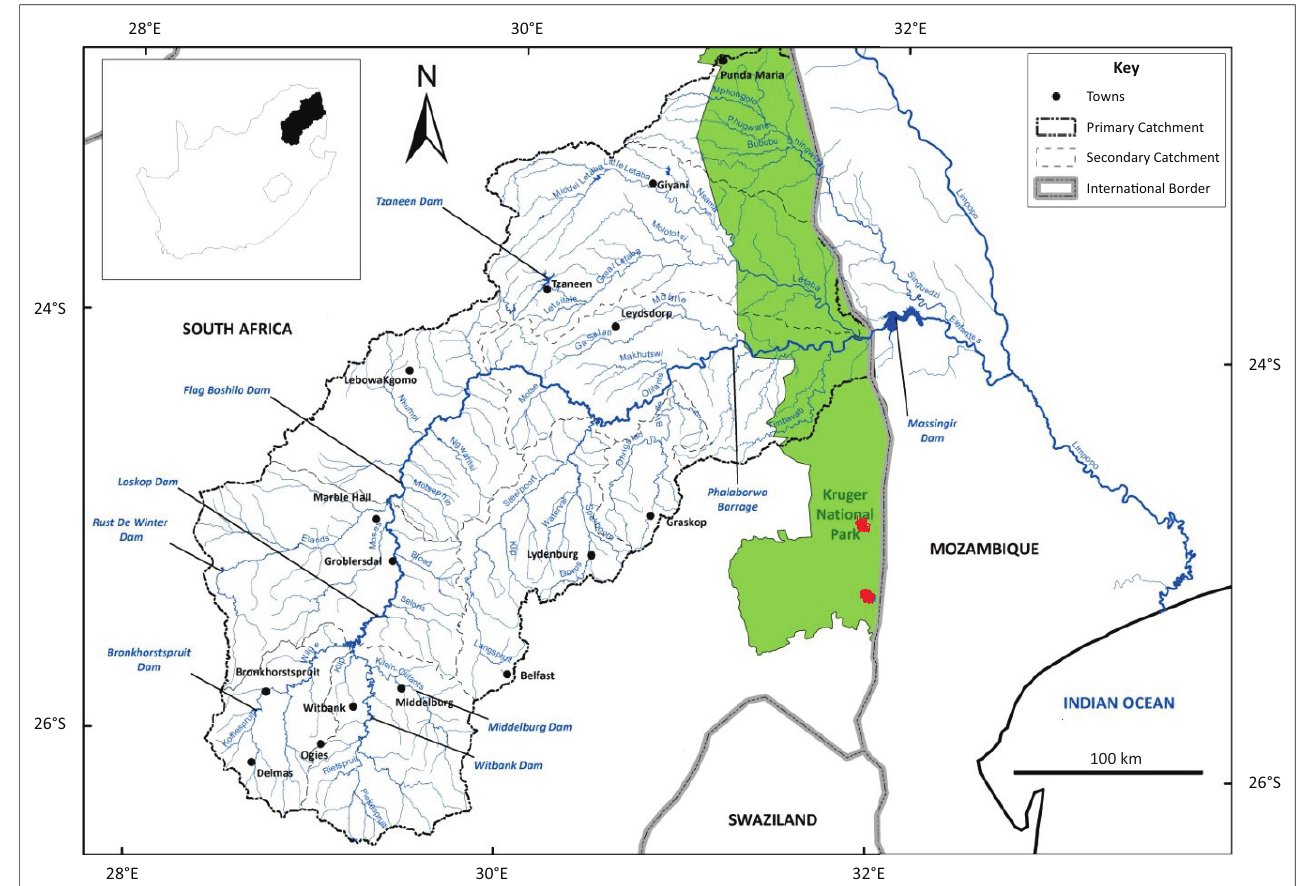
FIGURE 1: Map of the Kruger National Park indicated in green, with the locality of the two affected dams in